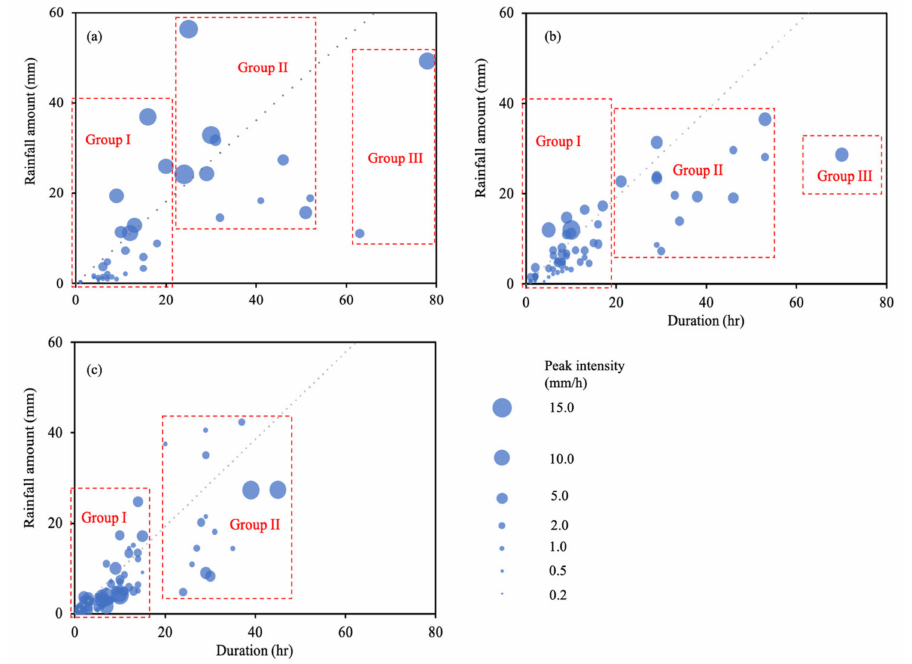
Figure 3. Distribution pattern of rain events in duration groups and intensity groups in CF ( a ), MF ( b ), and BF ( c ). Table 1. Detailed statistical information of measured rainfall parameters and penetration proportion for each rainfall